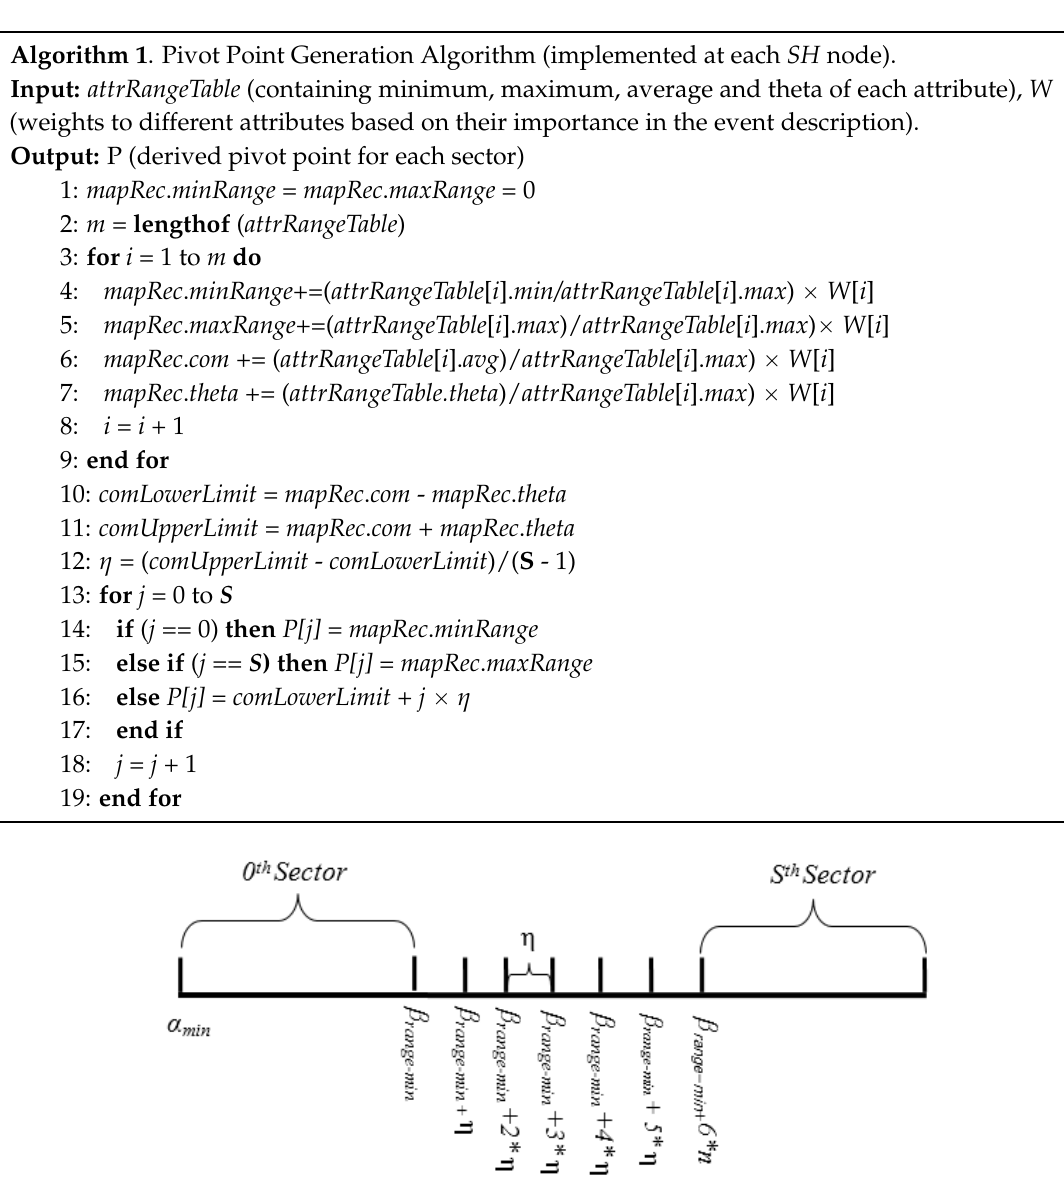
Figure 5. Pivot point generation example.